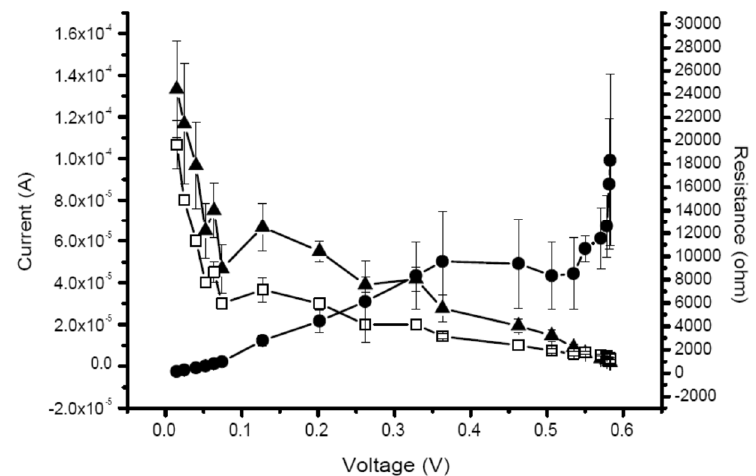
Figure 6. Changes in total internal resistance R (●), AC (□), and DC ( ▲ ) components versus average voltage in 300,000 s (34.7 days).